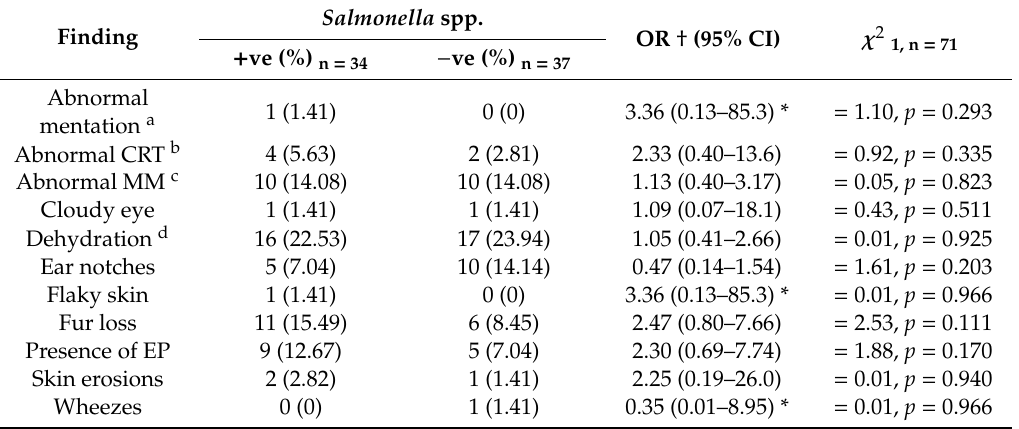
Table 4. Associations between physical examination findings and the presence of Salmonella in animals from Rottnest Island. OR = odds ratio, CI = confidence interval, CRT = capillary refill time, MM = mucous membranes, EP = external